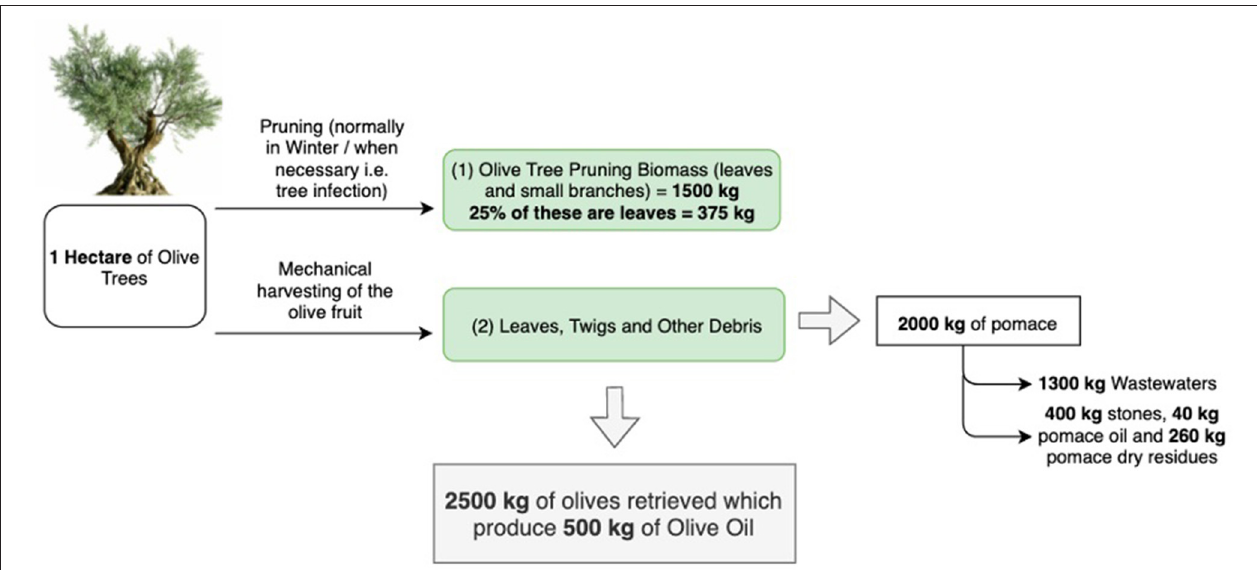
FIGURE 1 | Schematic designed to show the two processes where olive leaf by-products are generated. Reproduced from Manzanares et al. (2017).